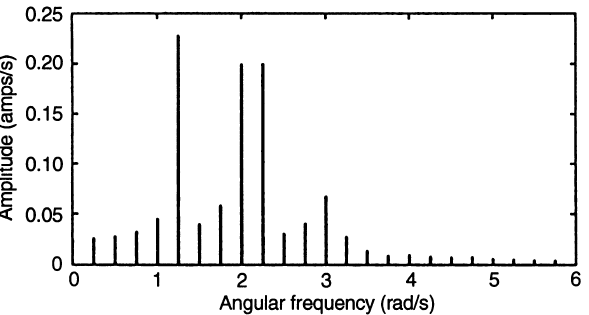
. The same scaling 3 and Y 1 2